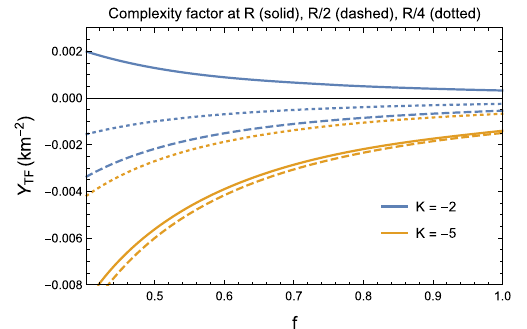
Fig. 2 Complexity factor temporal progression